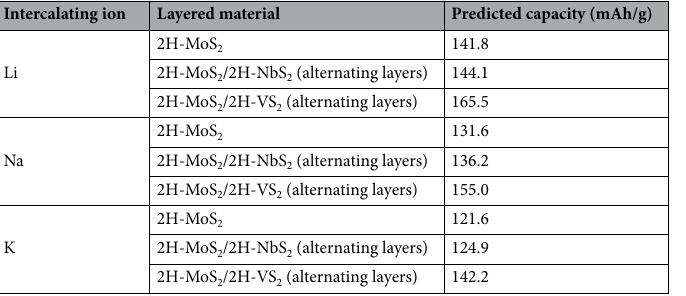
Table 4. Predicted theoretical capacities of 2H-MoS 2 and heterostructures with alternating layers of MoS 2 and NbS 2 and MoS 2 and VS 2 during Li, Na and K